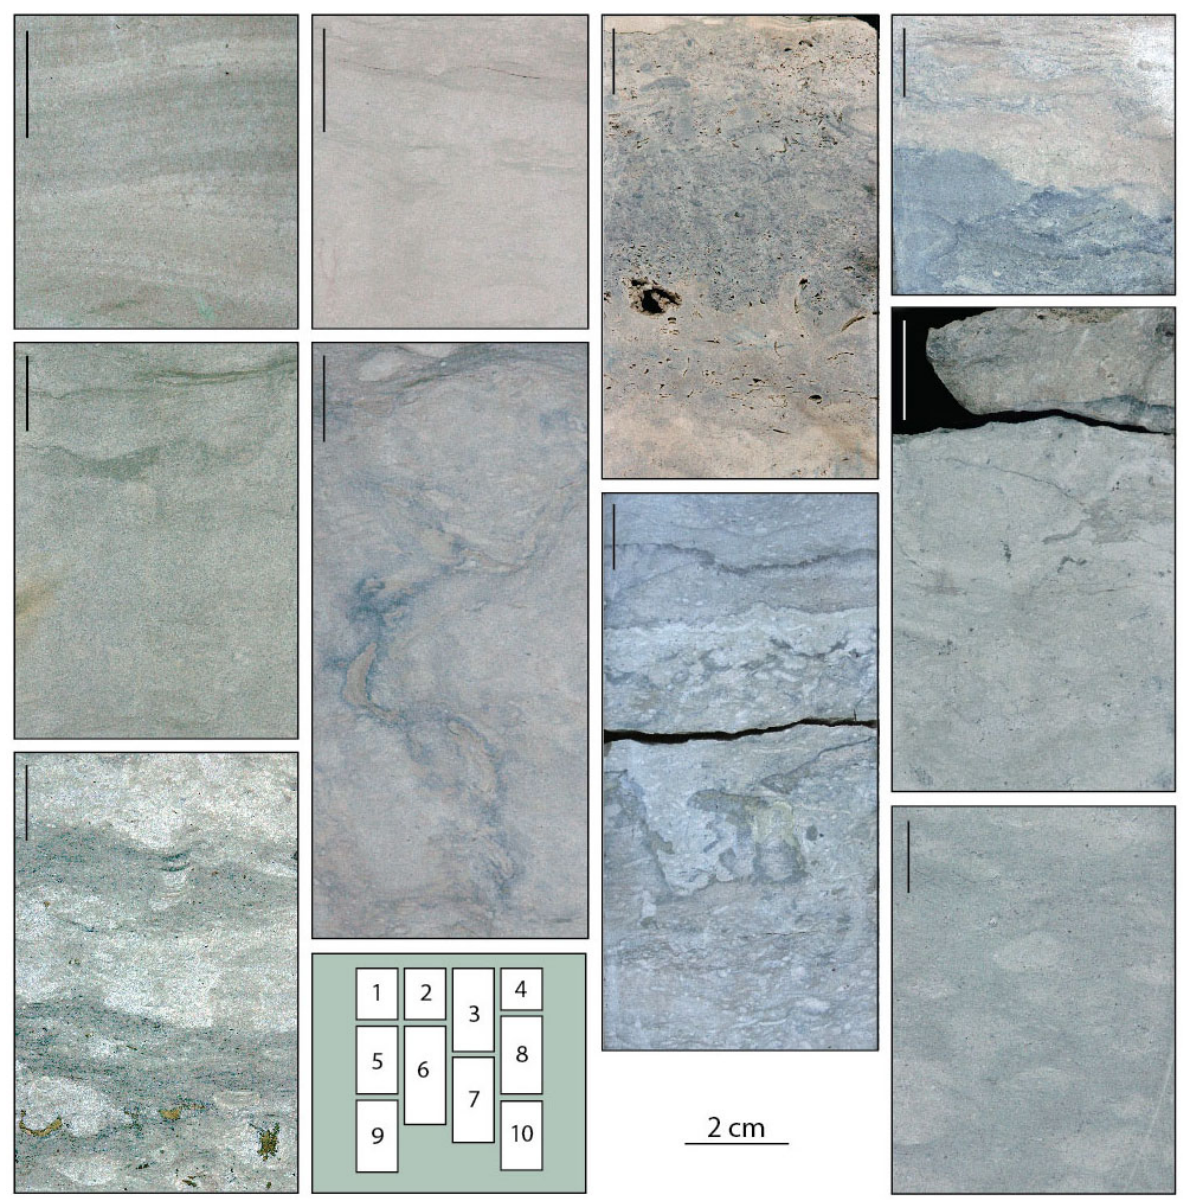
Fig. 3. Selected rock samples from the Suigu (S-3) core section. 1 . Low-angle inclined bedding in dolostone. Anhedral dolomite crystals are smaller in lighter beds. Green clay-grade material is concentrated in disjointed films and patches (burrows?), fractures and open vugs are observed. Interval 11.55(cid:150)11.61 m. 2 . Dolostone with irregular interbeds of argillaceous dolostone.